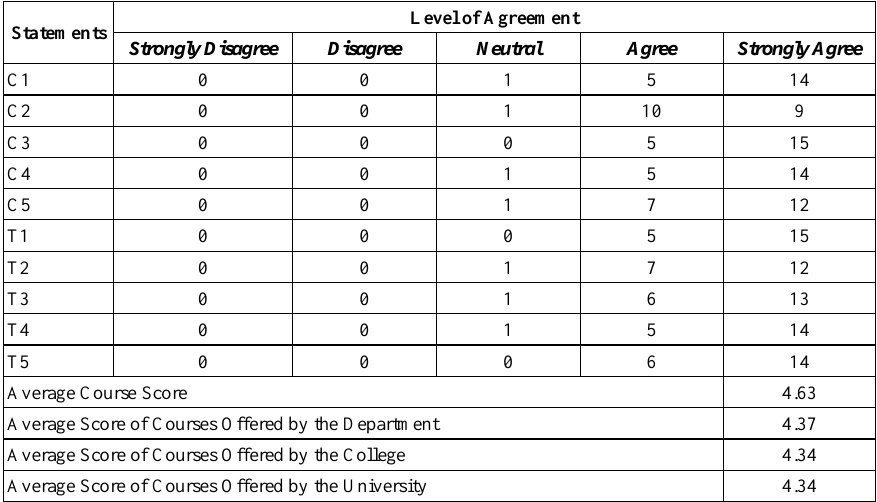
Table 5. Course evaluation for Computer